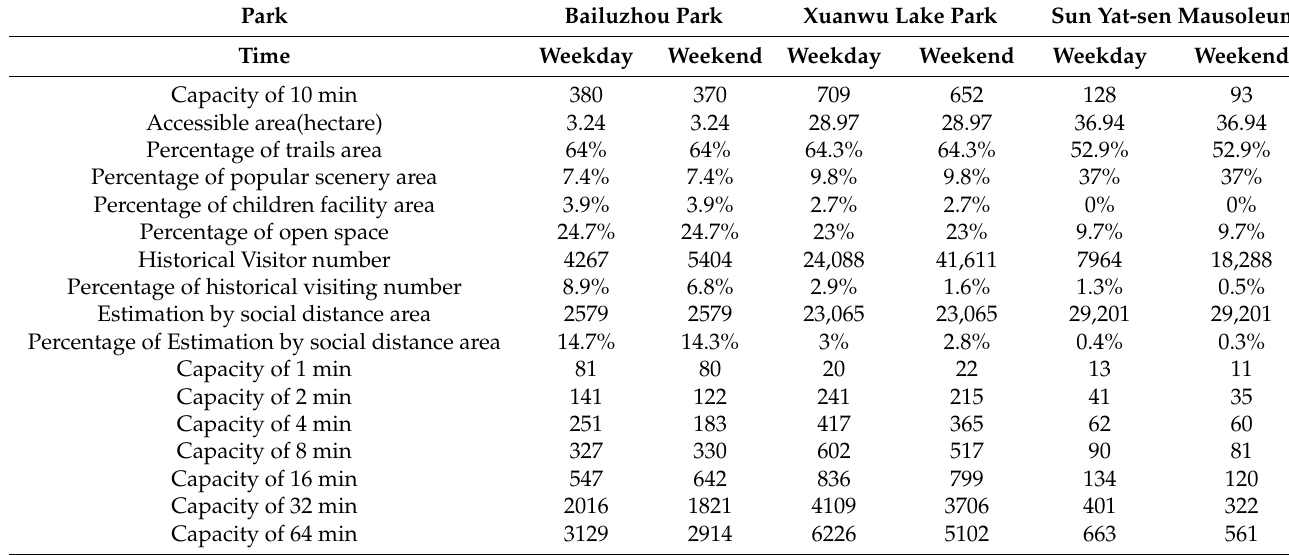
Table 4. The capacities of the three parks considering a critical period of 10 min to induce infection.